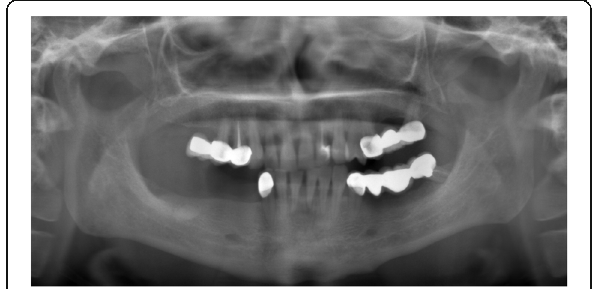
Fig. 1 Panoramic X-ray evaluation of